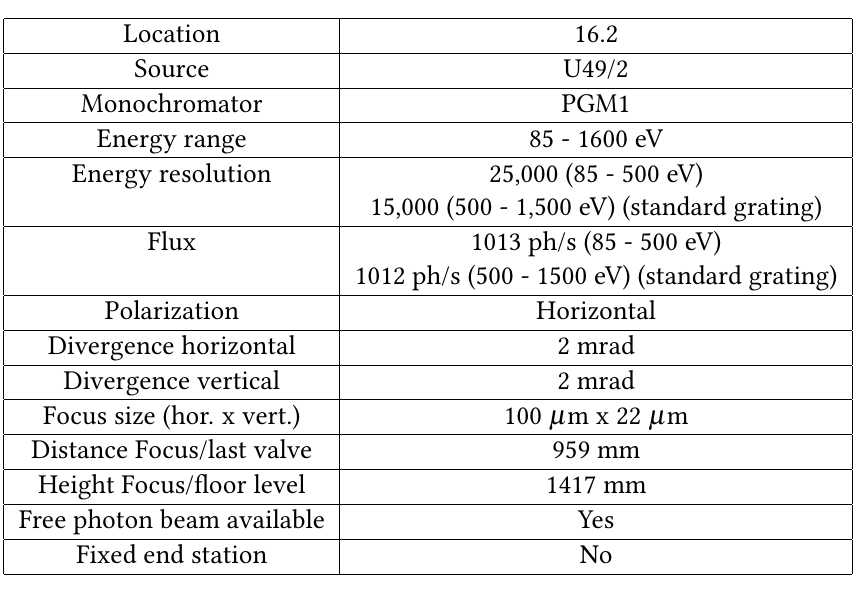
Table 2: Technical parameters of beamline U49/2